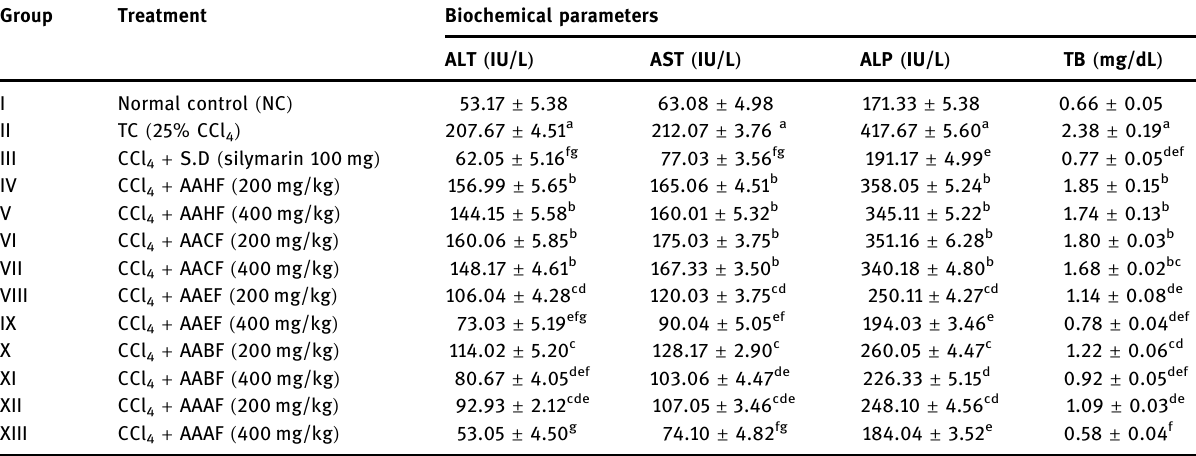
Table 1: E ff ect of di ff erent solvent fractions of AAME on serum biochemical parameters against CCl 4 - induced toxicity in mice